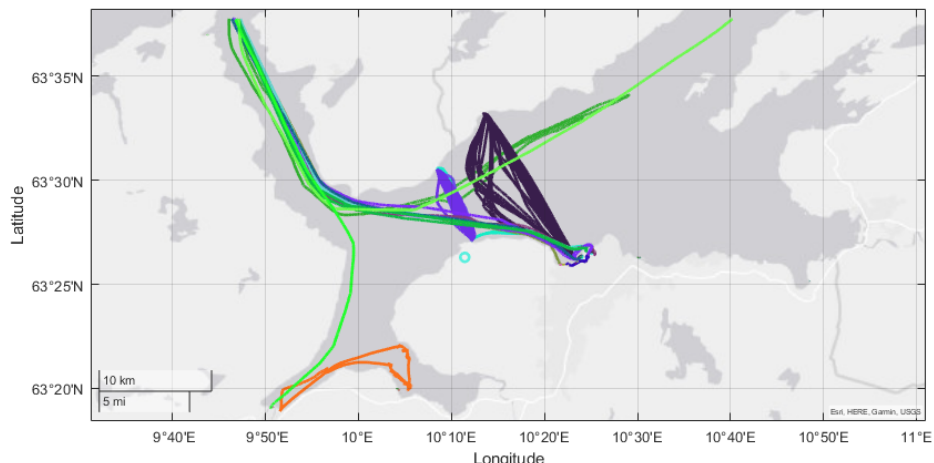
Figure 7. Historic automatic identification system (AIS) data trajectories (after interpolation) of different vessels on one day, plotted on the geographic map in the Trondheim fjord area.